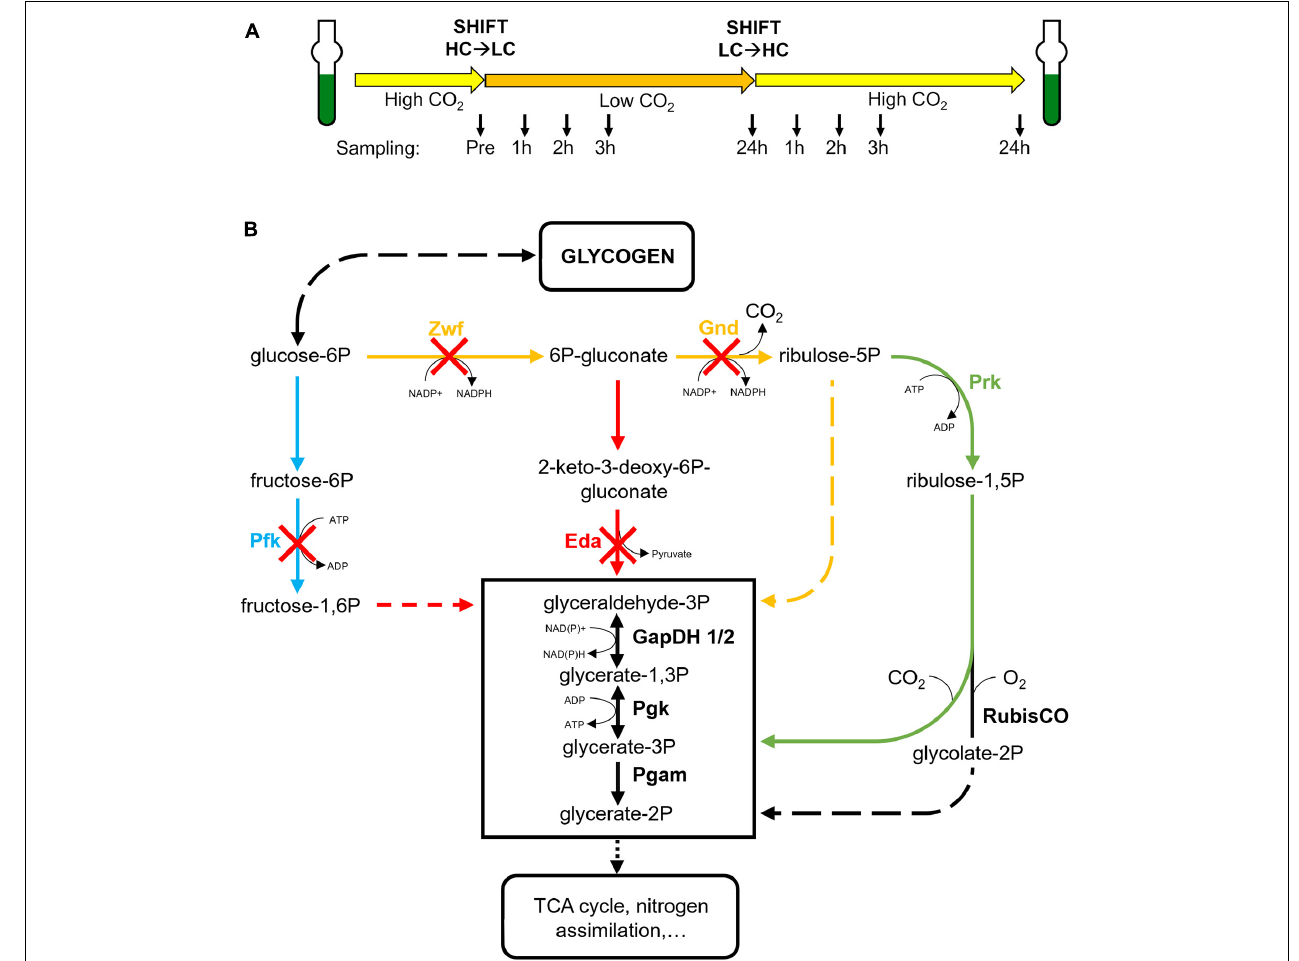
FIGURE 1 | Experimental design and affected enzymes in the studied strains. (A) All strains were pre-cultured under high CO 2 (5%, HC) and then shifted for 24 h into low CO 2 (ambient air, 0.04%, LC) and afterwards again into HC conditions. At defined time points (indicated by arrows) samples were taken for glycogen and metabolome analyses. (B) Schematic display of the primary carbon metabolism in cyanobacteria with the CBB cycle, the oxidative pentose-phosphate